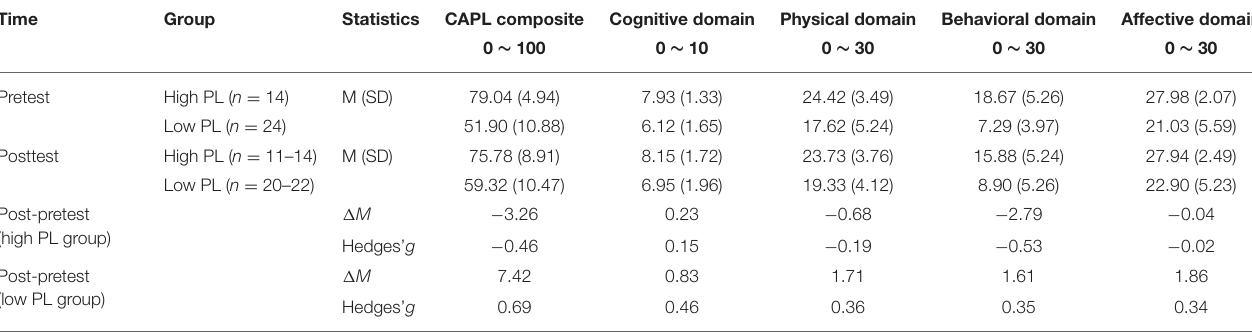
TABLE 5 | Descriptive results of CAPL assessments for the students intervened by